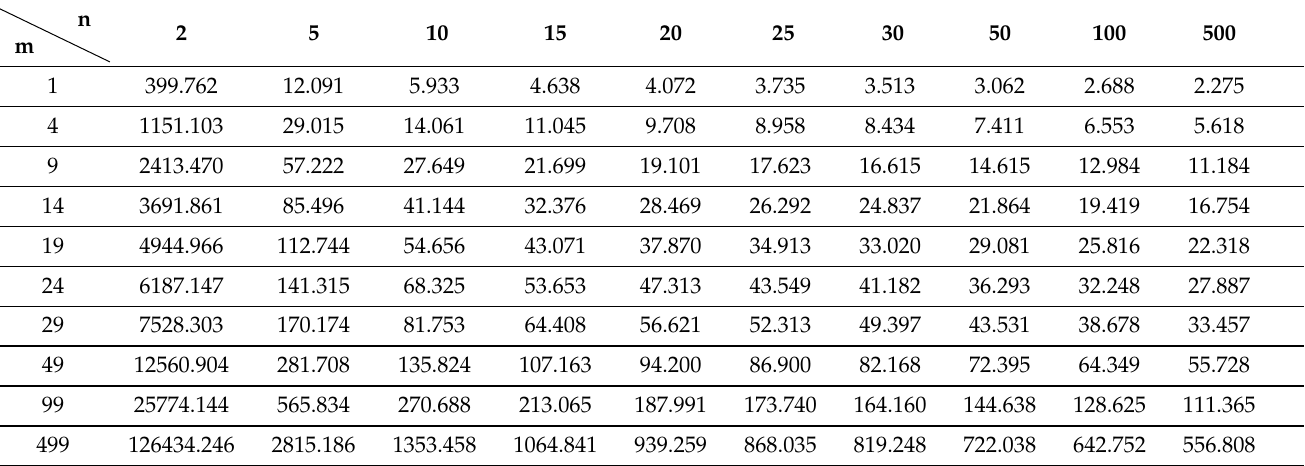
Table 2. 95th percentiles of the maximum order statistics of U 1 , U 2 , · · · , U m .